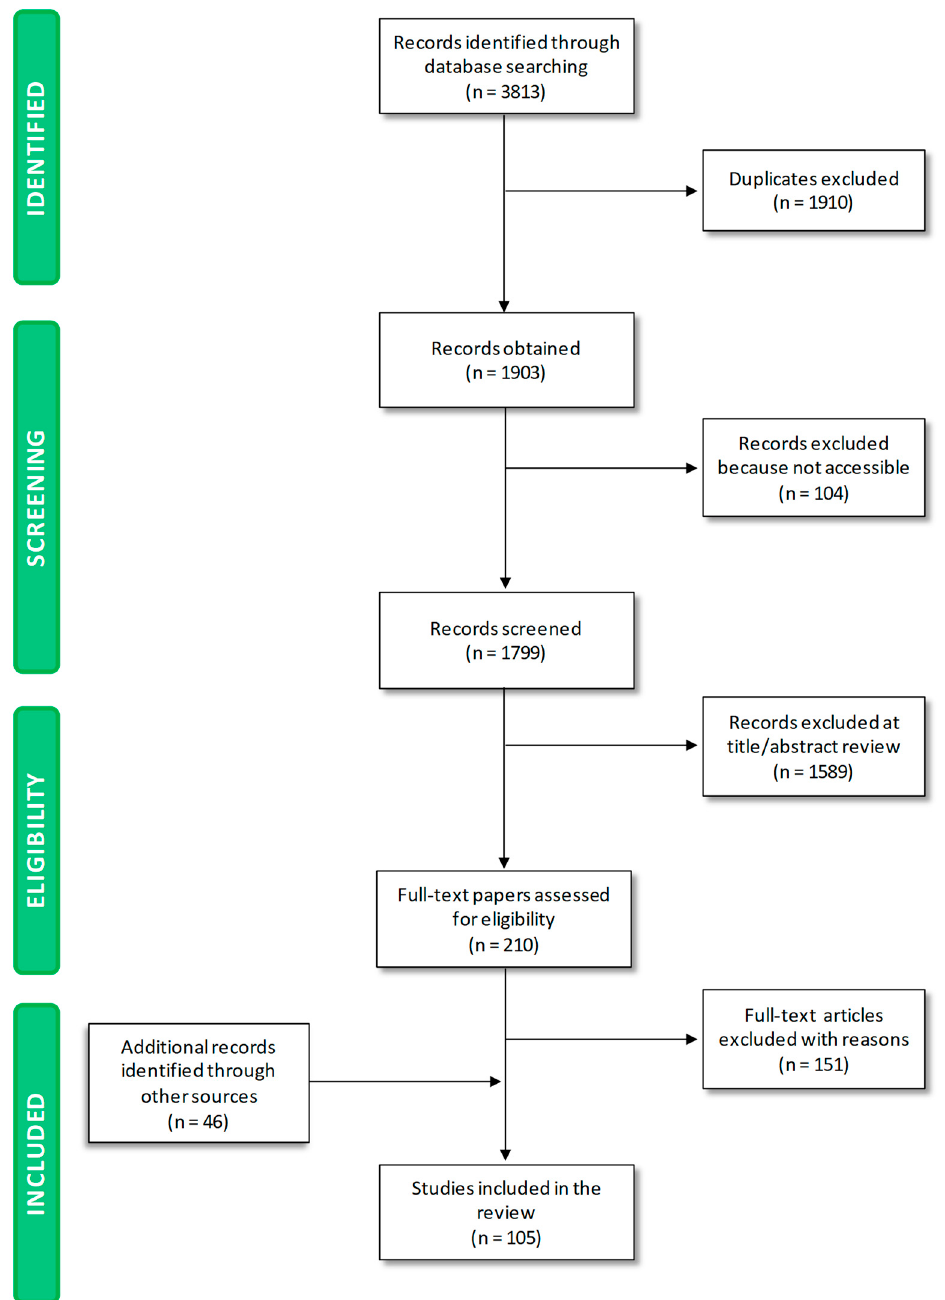
Figure 1. PRISMA (Preferred Reporting Items for Systematic Reviews and Meta-Analyses) flow diagram.